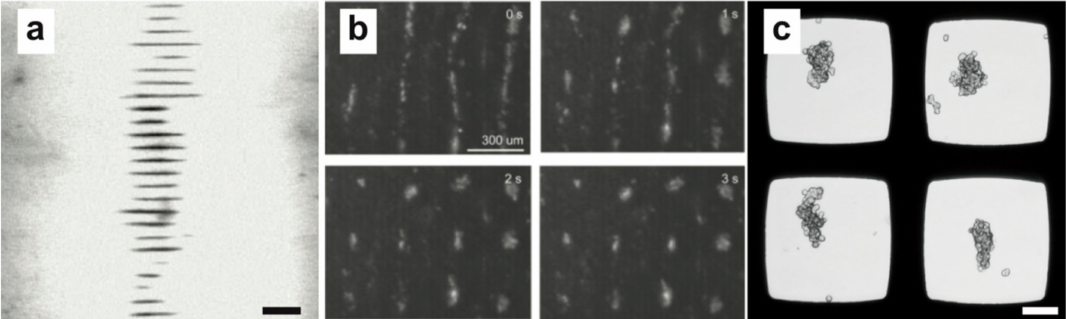
Figure 3. Multiple acoustic pressure nodes are an effective way to parallelize tissue formation. Numerous pressure nodes can be obtained by using multiple wavelengths in a single resonator chamber ( a ) (scale bar: 1 mm) [29], producing pressure nodes arrays through orthogonal one-dimensional pressure fields ( b ) [30] or using multiple microwells where the half-wavelength ( λ /2) criterion is